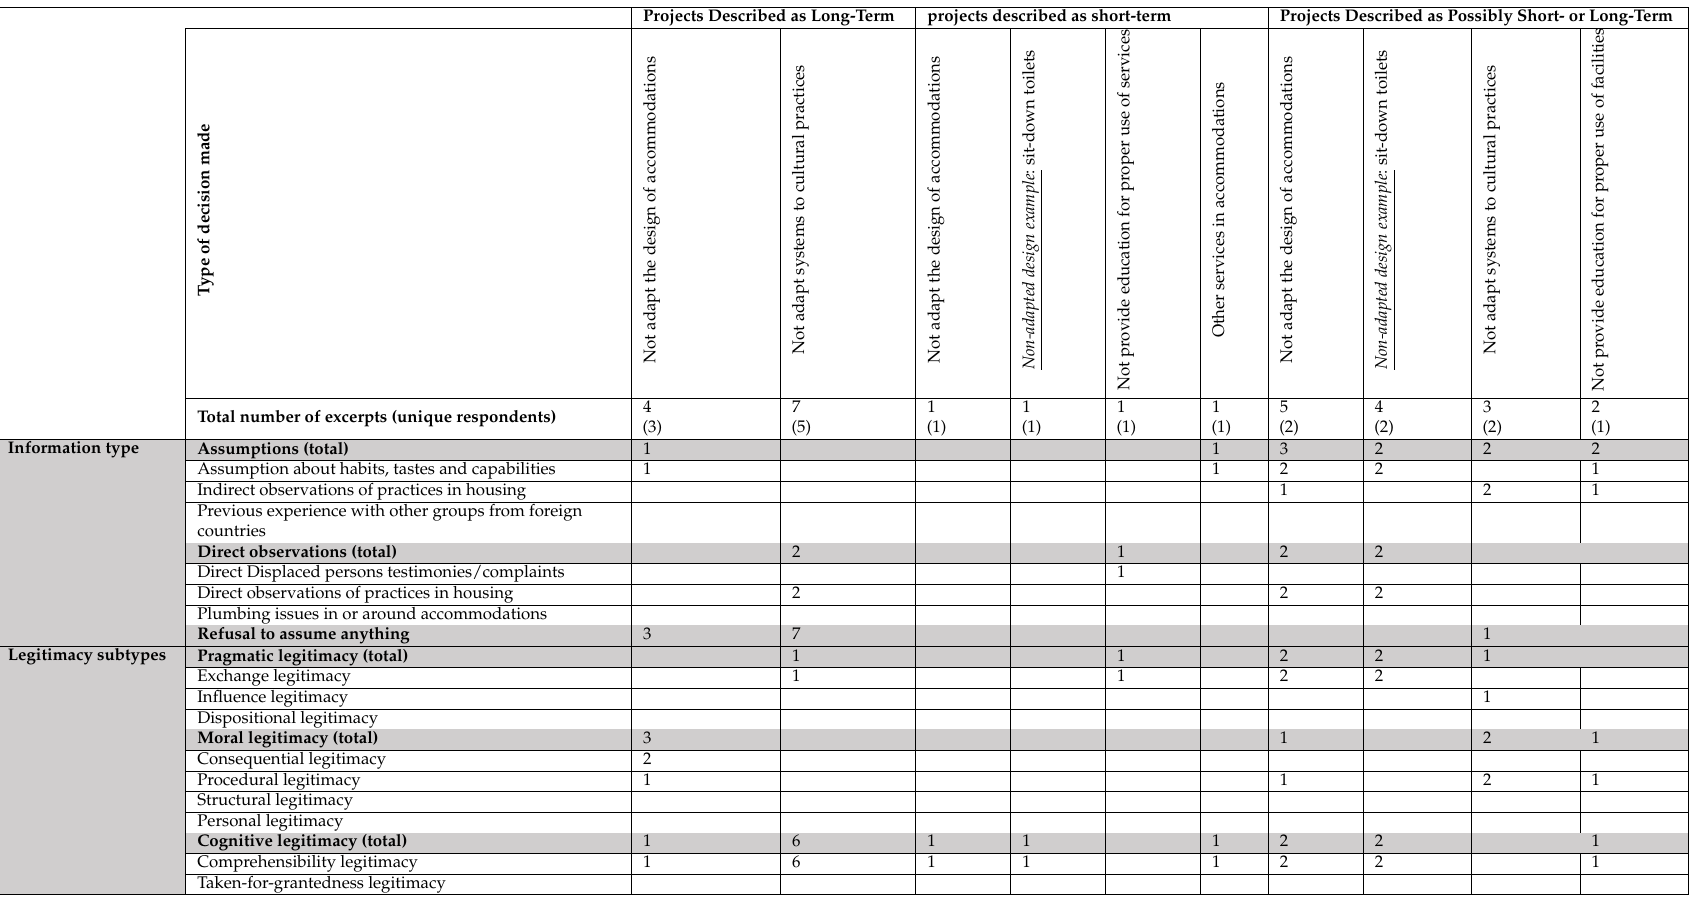
Table A2. Decisions made and legitimacy used while delegitimizing the inclusion of cultural